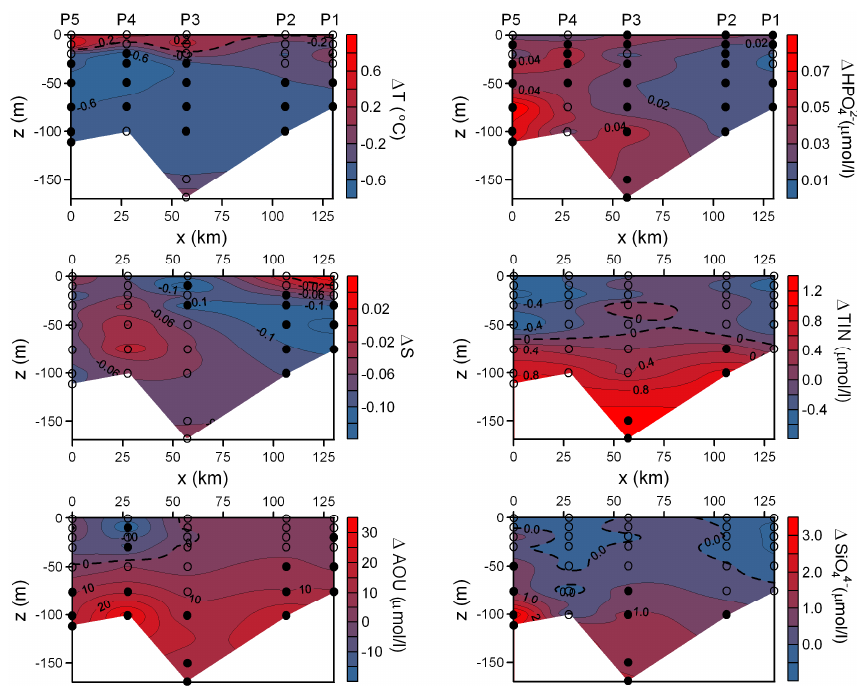
Fig. 8. As in Fig. 7, but for difference between 1991–1998 and 1960–2010 period. Full circles denote significant difference between two periods at 95% level.